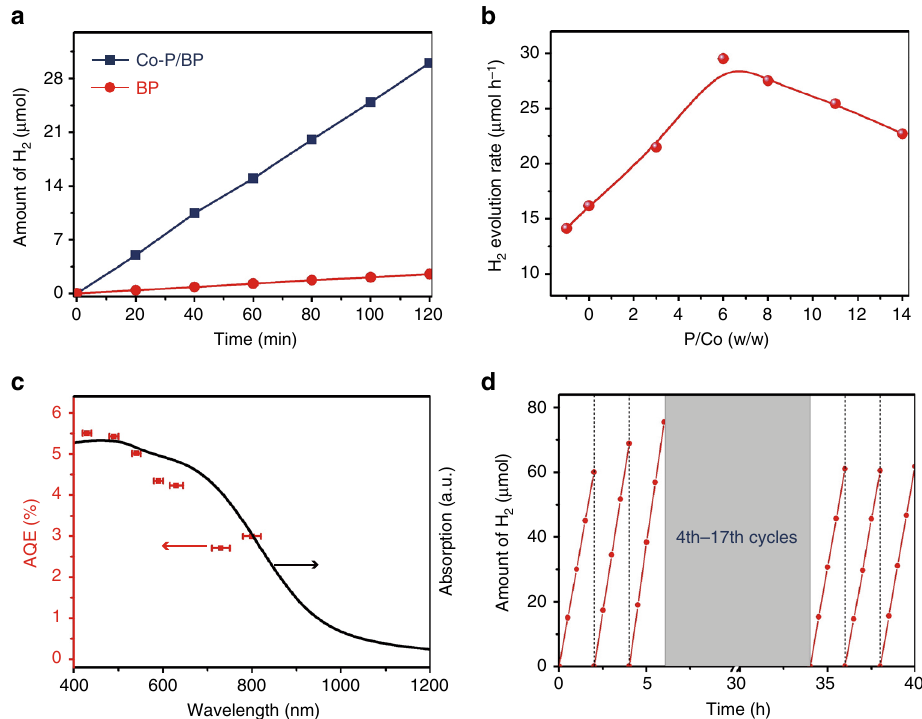
Fig. 4 Photocatalytic H 2 evolution over the BP-based catalysts. a Typical time courses of H 2 evolution over the BP and Co-P/BP nanosheets under Xe lamp illumination (PLS-SXE300C, λ ≥ 420 nm). The mass ratio of Co to P is 1/3. b Effect of the mass ratio of Co to P on the photocatalytic activity in the Co-P/ BP nanosheets. c Wavelength-dependent AQE (red squares) of H 2 evolution over the optimal Co-P/BP catalyst irradiated by a 300-W Xe lamp using a bandpass fi lter of λ ± 10 nm for 430, 490, 540, and 590 nm; λ ± 15 nm for 630 nm; λ ± 30 nm for 730 and 800 nm. The errors bars represent wavelength error of fi lters. d Stability of photocatalytic H 2 evolution over the Co-P/BP catalyst in pure water. For all the photocatalytic water-splitting experiments, 40 mg of the catalyst was dispersed in 150 mL pure water (pH = 6.8) followed irradiation by 300-W Xe lamp with output power of 100 mW cm − 2